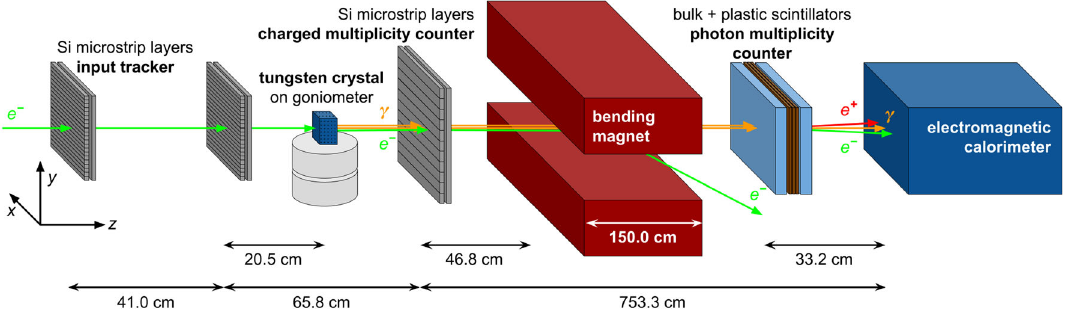
Fig. 4 Scheme of the DESY experimental